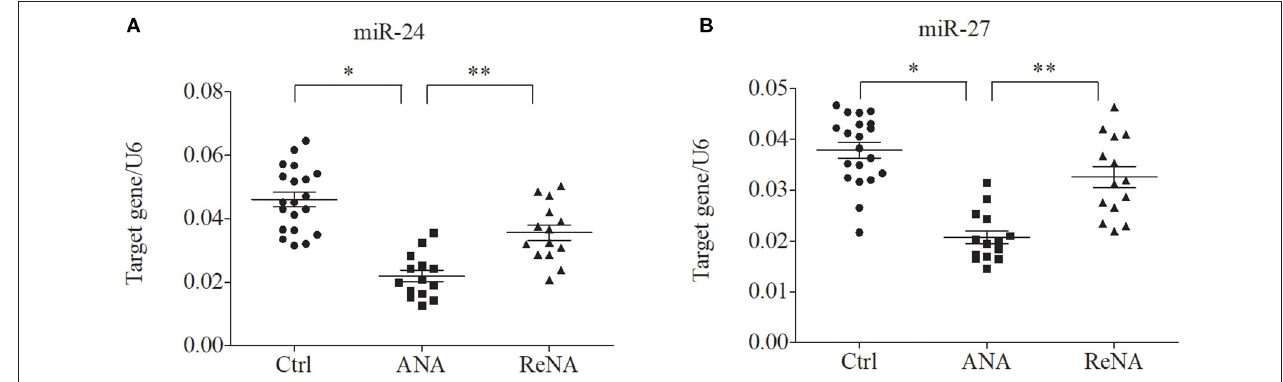
FIGURE 3 | Children with INS have reduced expression of miR-24 and miR-27 in CD4 + CD25 − T cells. Expression of miRNAs (relative to U6) were determined by real-time PCR. (A) Expression levels of miR-24. (B) Expression levels of miR-27. * P < 0.05 and ** P > 0.05.